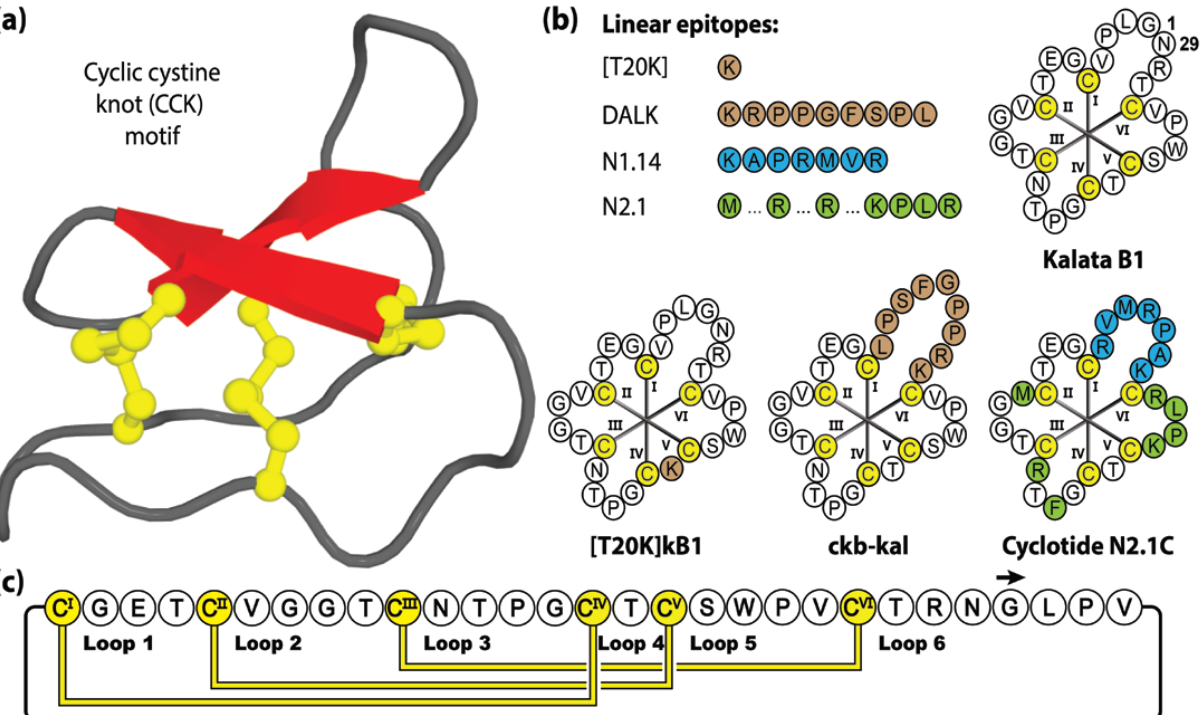
Figure 4. Structure and sequence of kalata B1, prototypic Möbius cyclotide member, and three grafted examples. ( a ) Three-dimensional structure of Möbius cyclotide kalata B1. ( b ) Peptide sequences of kalata B1 and four bioactive epitope examples, with their corresponding three grafted cyclotide products. ( c ) Amino acid sequence, disulfide bond connectivity and loop nomenclature of kalata B1. Cysteine residues are numbered and highlighted in yellow, with non-native epitope inclusions represented by brown, blue or green shading. Blue and green shading distinguishing the first (N1.14) and second generations (N2.1) of bioactive epitope sequences generated via sequential bacterial display libraries, respectively.